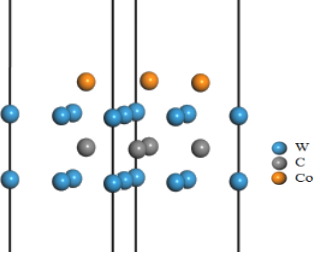
Figure 1. WC-Co interface model with vacuum layer.